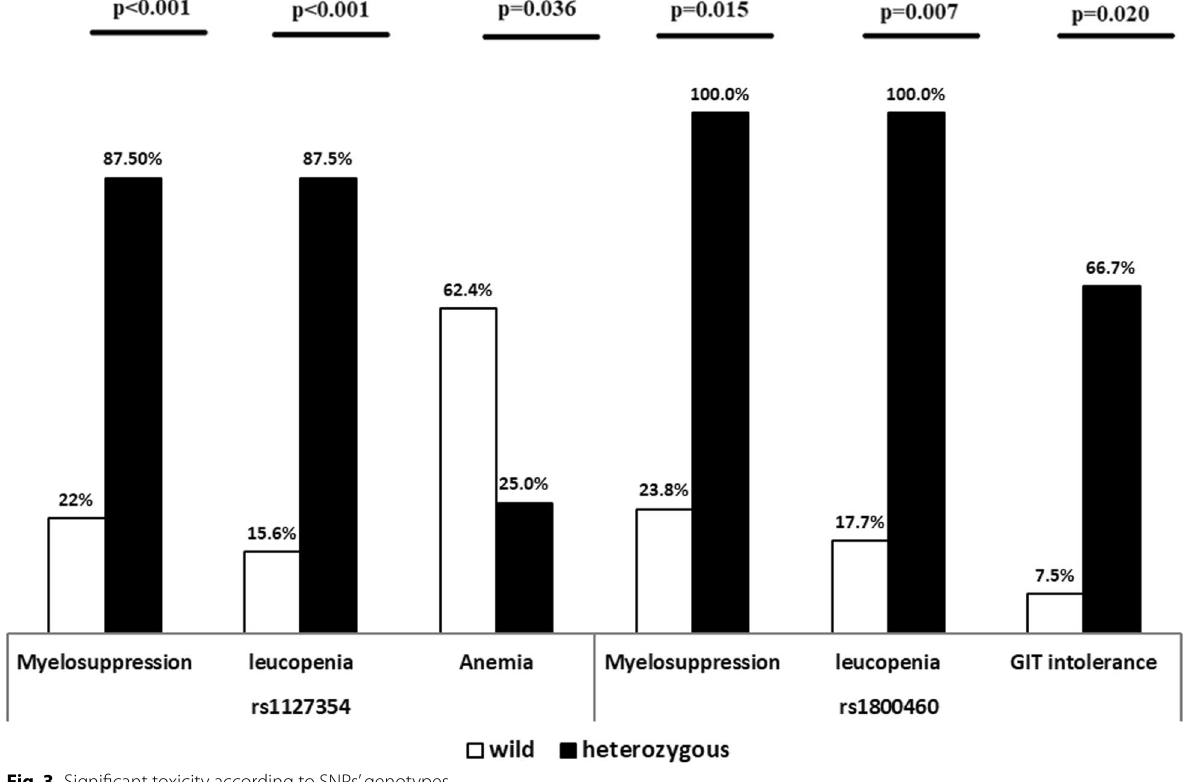
Fig. 3 Significant toxicity according to SNPs’ genotypes